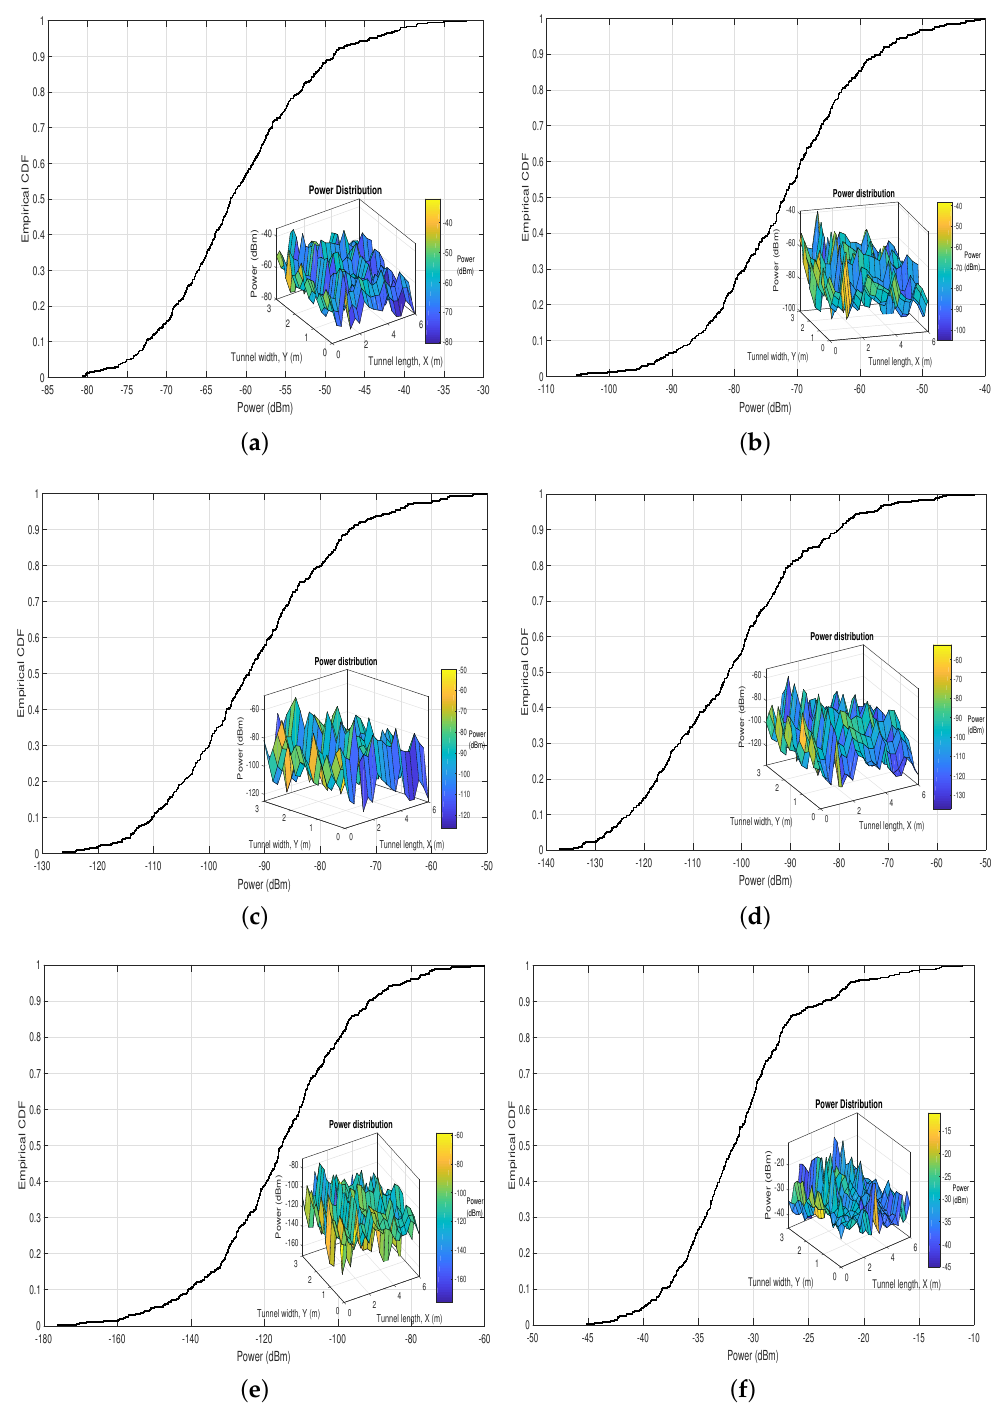
Figure 5. Empirical CDF and distribution of the received power in the UM-VLC scenario with ( a ) 40, ( b ) 60, ( c ) 100, ( d ) 150, ( e ) 200 dust particles in the hemispheric area, and ( f ) UM-VLC reference scenario, Reprinted from ref.